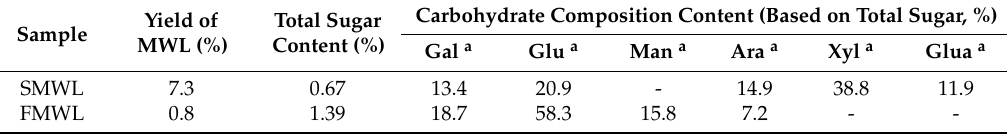
Table 1. Yield and Carbohydrate Composition of SMWL and FMWL Fractions (% dry weight). Carbohydrate Composition Content (Based on Total Sugar, %) Yield of Total Sugar Sample MWL (%) Content (%) Gal a Glu a Man a Ara a Xyl a Glua a SMWL 7.3 0.67 13.4 20.9 14.9 38.8 FMWL 0.8 1.39